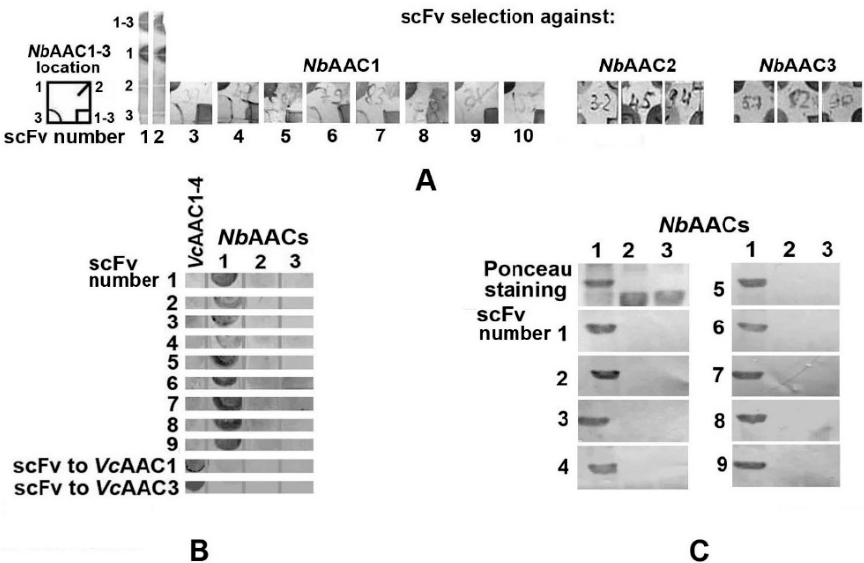
Figure 2. ( A ) Dot blots of 10 selected recombinant Abs showed their specific recognition of the chimeric proteins Nb AAC1 and Nb AAC1-3 but not Nb AAC2 and Nb AAC3. Dot blot analysis of some recombinant Abs selected against Nb AAC2 and Nb AAC3 demonstrated non-specific staining of three or four chimeric proteins placed at the corners of nitrocellulose squares, but none of the scFv variants specifically recognized these Nb AAC1-3 fragments. ( B ) As a control, we used the Vc AAC1- 4 chimeric protein carrying the outer loops of four microsporidia Vairimorpha ceranae ATP/ADP transporters recognized by previously constructed Vc AAC1- and Vc AAC3-specific recombinant Abs. ( C ) Binding of selected scFv fragments to the Nb AAC1 protein band, but not to Nb AAC2 or Nb AAC3, was shown by immunoblotting.